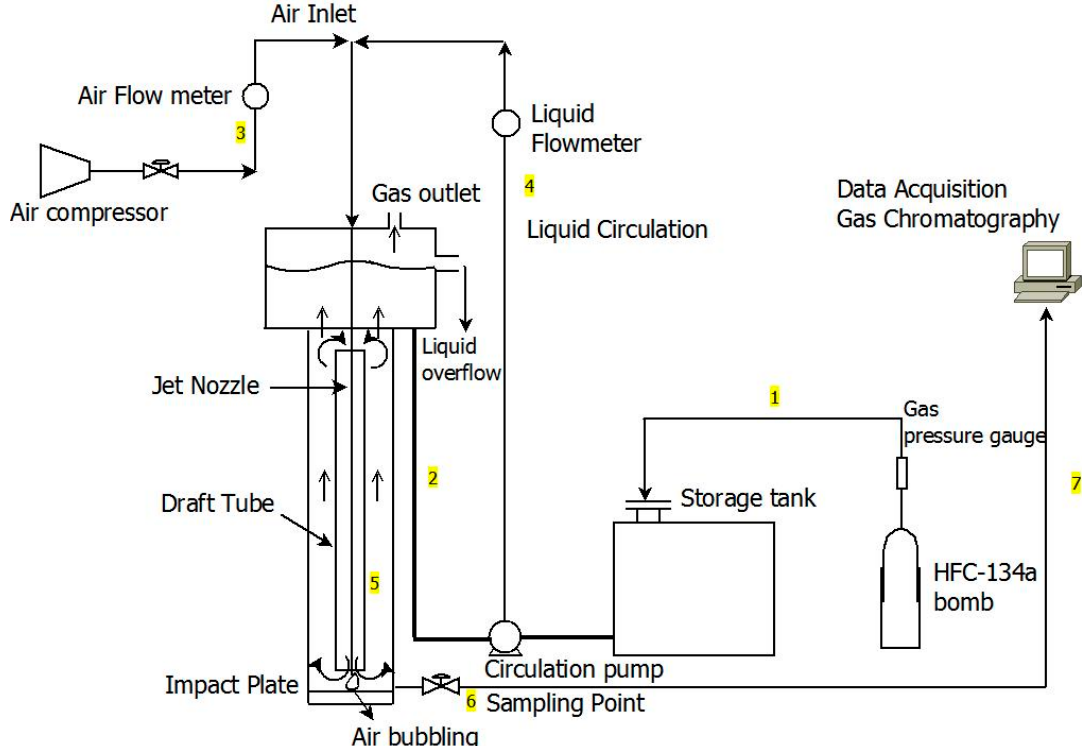
Figure 1. The flow diagram of the experimental setup (1. Air bubbling (HFC 134a to brackish water), 2. Feed from storage tank to JLR, 3. Air flow parameter, 4. Liquid circulation parameter, 5. Separation gas in JLR, 6. Sampling product, 7. Analyzing data with Gas Chromatography-Mass Spectrometry).